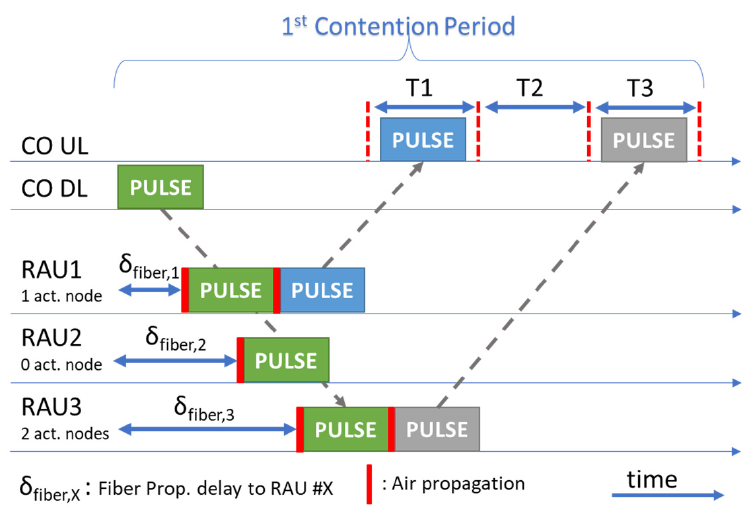
Figure 2. First Contention Period example for determining which RAUs contain active nodes. Based on reporting pulses’ arrival times, the CO can detect which RAUs contain active nodes and which do not. In the example above, RAUs 1 and 3 contain active nodes.